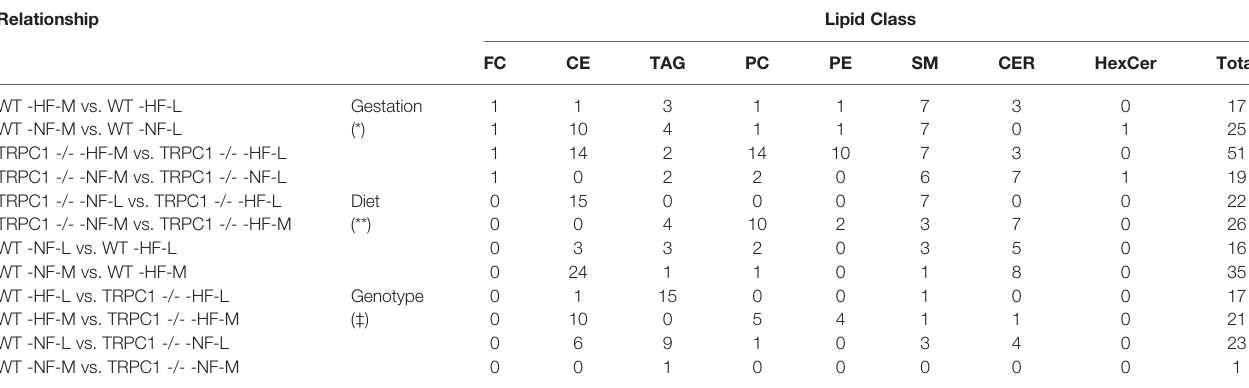
TABLE 1 | Summary of lipid classes and relationships observed by 1-way ANOVA (p < 0.05) with.